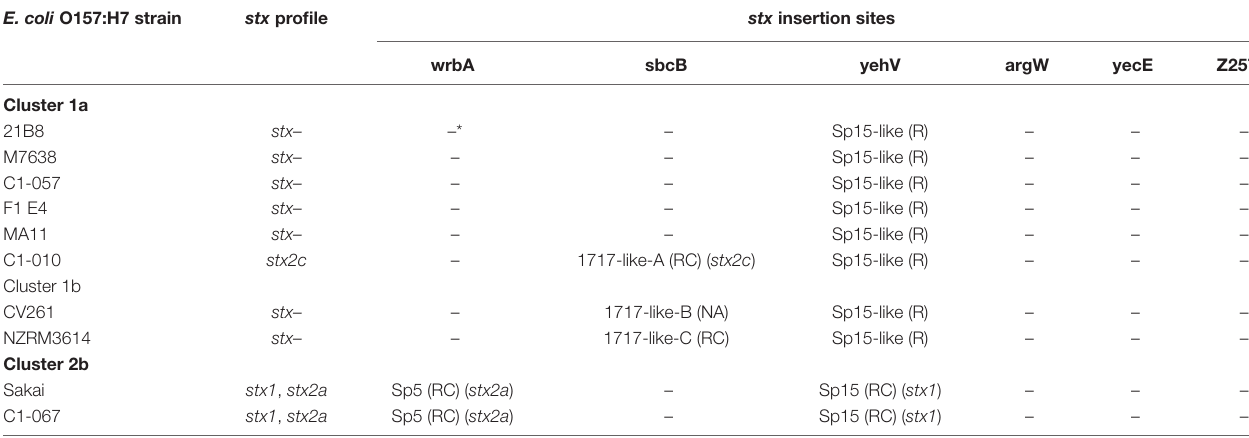
TABLE 4 | Comparison of prophages at the six stx insertion sites in Escherichia coli O157:H7 strains Sakai, the three newly sequenced strains, and six stx -negative strains from the NCBI